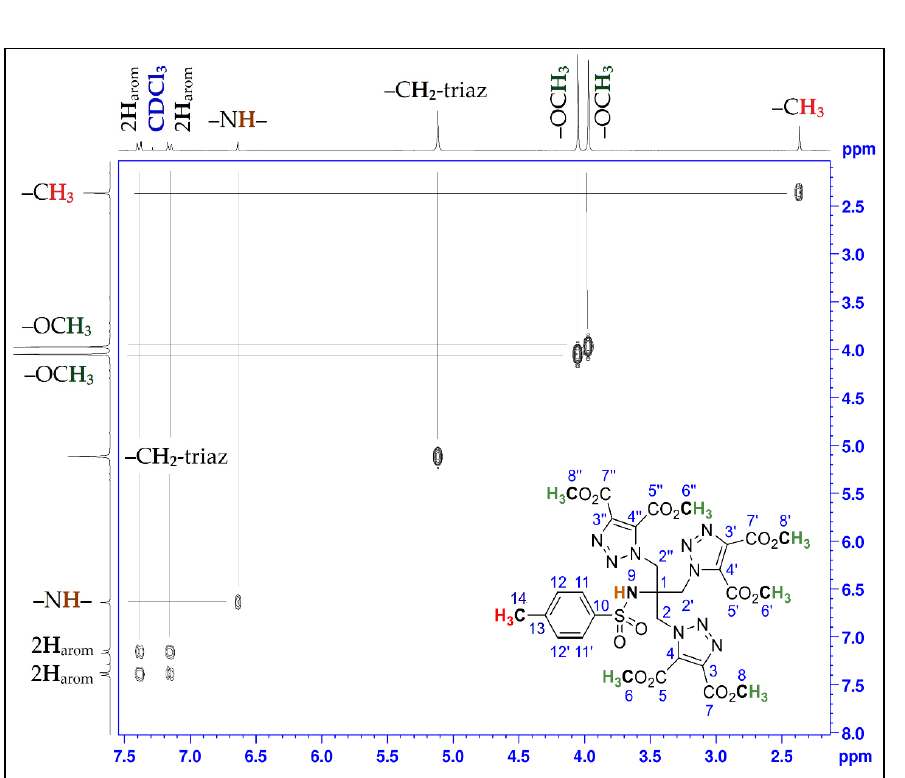
Figure 1. 2D COSY spectrum of compound ( 3 ). Table 1. 1 H (300 MHz) and 13 C (75 MHz) NMR spectral data for compound ( 3 ) in CDCl 3 , including results obtained by homonuclear 2D shift-correlated and heteronuclear 2D shift-correlated HMBC. Chemical shifts ( δ in ppm) and coupling constants ( J in Hz).